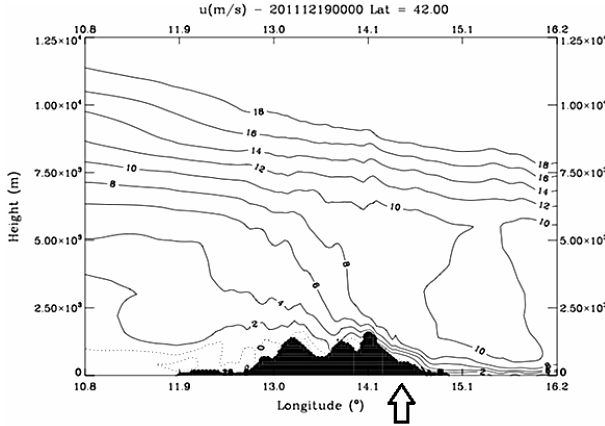
Figure 4. Vertical cross section at 42 ◦ N of the zonal wind showing the deep gravity wave generated by the Apennines. The arrow shows the approximate longitude of the wind